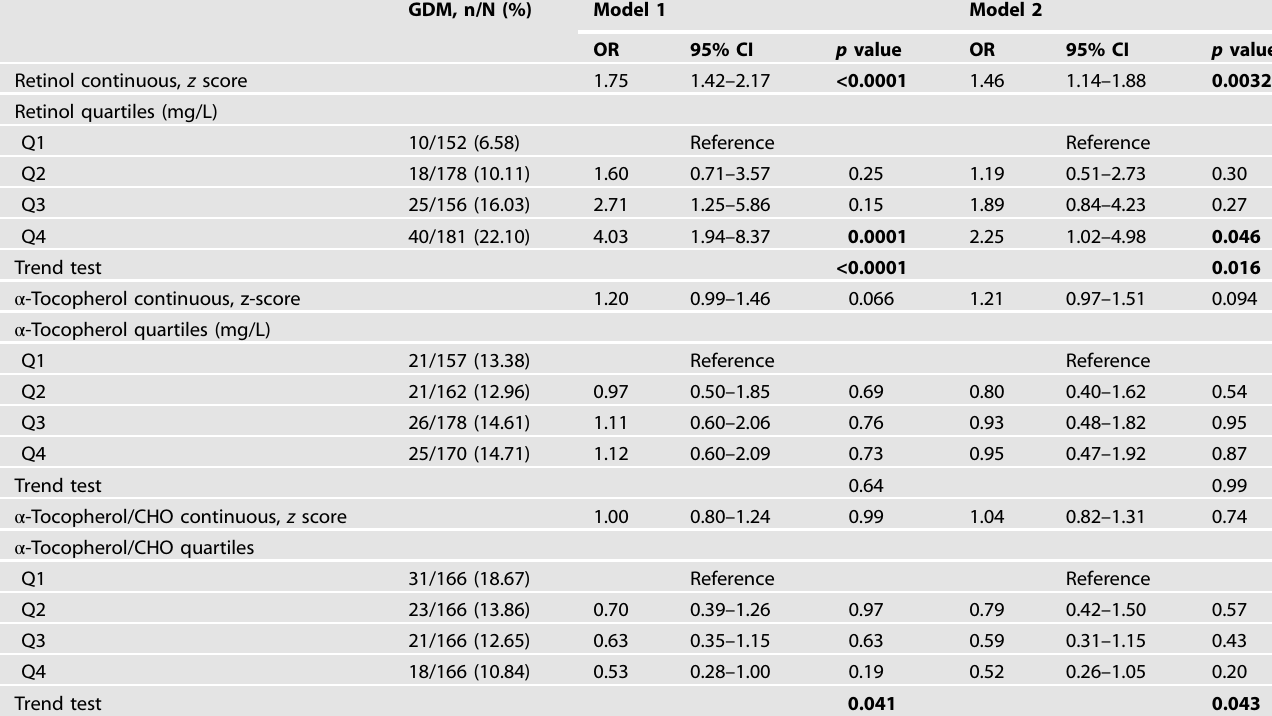
Table 2. Univariate and multivariate associations of maternal antioxidant vitamins A and E with odds of